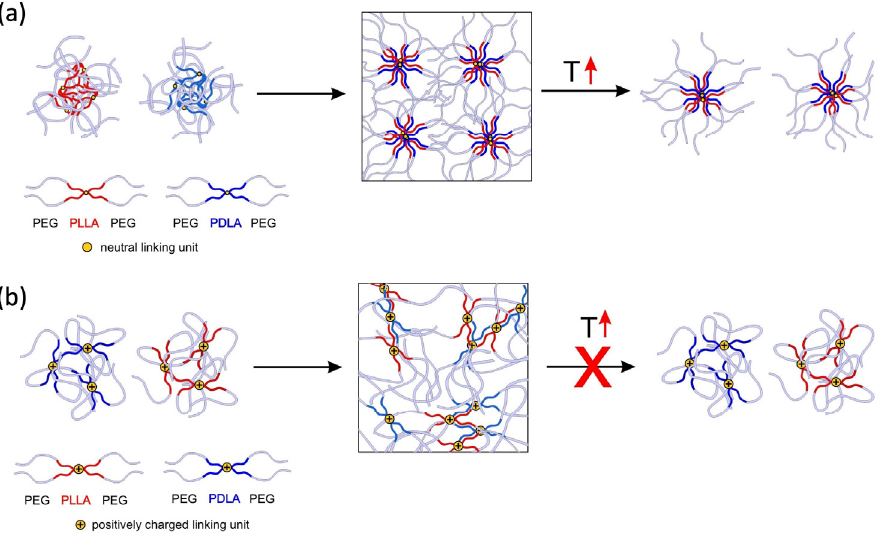
Figure 5. Model of hydrogel formation for block copolymers I -L and I -D ( a ) and block copolymers II -L and II -D and III -L and III -D ( b ).